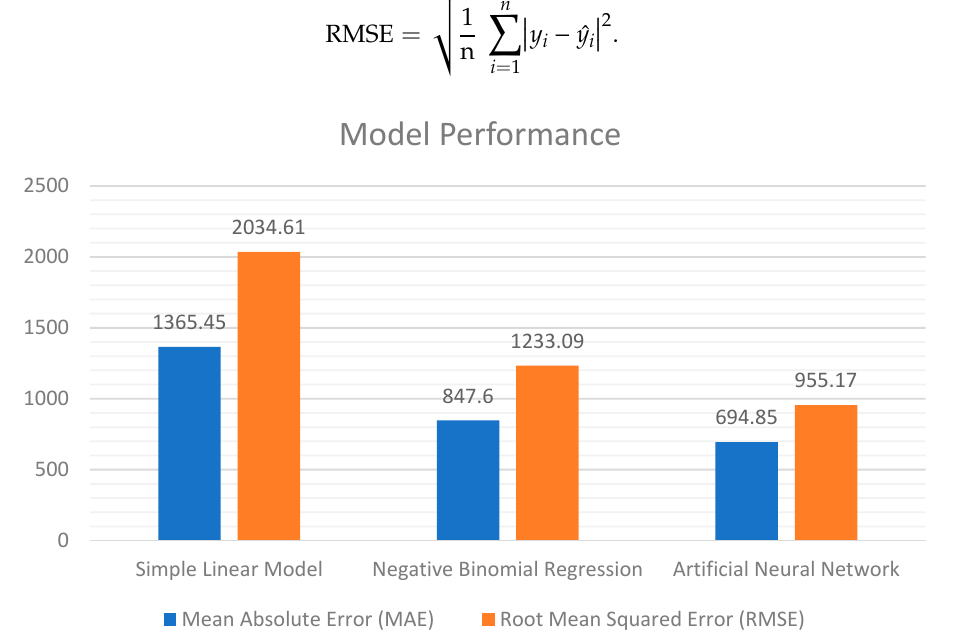
Figure 6. Model predictive performance: Mean Absolute Error (MAE) and Root Mean Squared Error (RMSE).